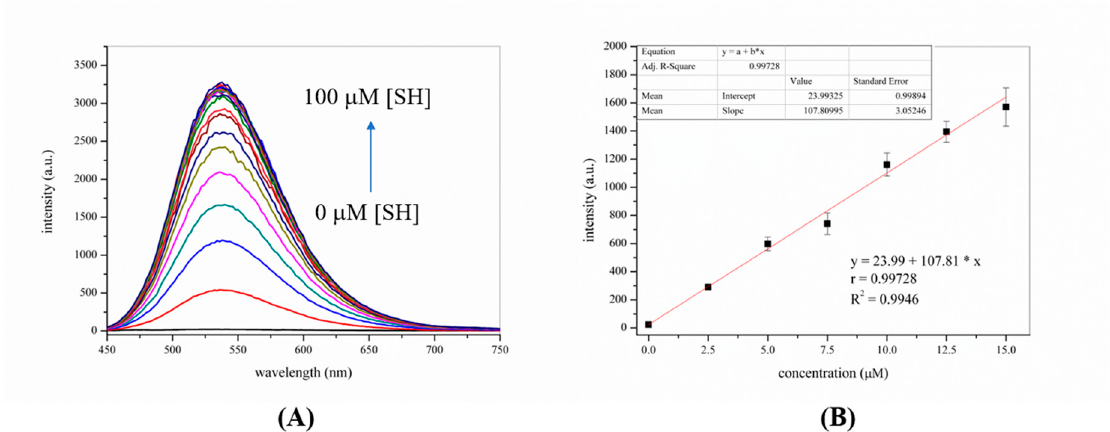
Figure 2. ( A ) Fluorescence spectra of 10 μ M probe ‐ KCP upon the addition of 4 ‐ methoxy thiophenol (0–100 μ M); ( B ) The linearity of the probe ‐ KCP fluorescence intensity versus thiophenol concentration (0–15 μ M). λ ex = 410 nm and λ em = 540 nm. Relative standard deviation (RSD), n =